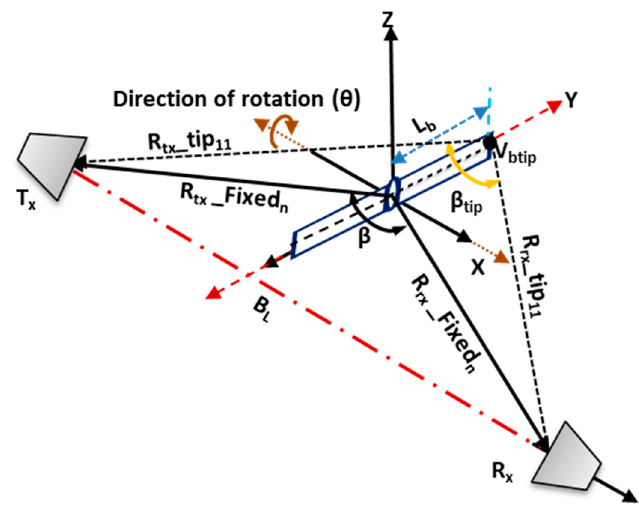
Figure 3. Drone rotating blades range profiles in FSR (Forward Scattering Radar) geometry.